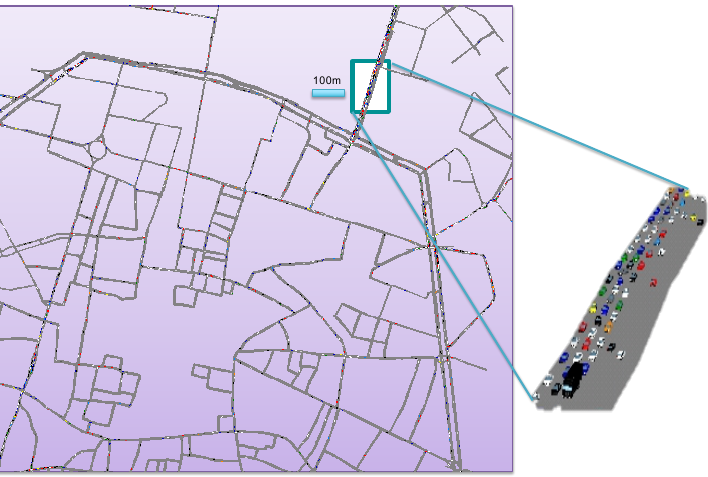
Figure 3. Simulated scenario: an area of 2.88 km 2 of Bologna (Italy) downtown with 455 vehicles on